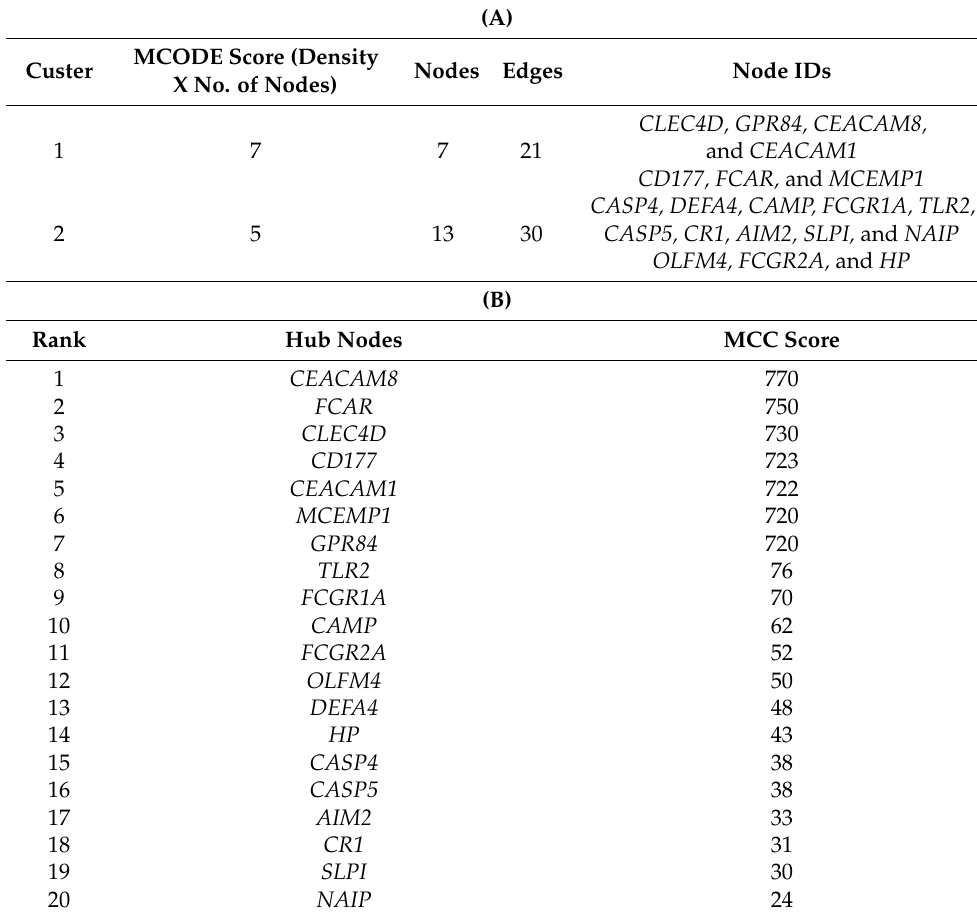
Table 4. ( A ) Closely interlinked regions in the PPI network are clustered by MCODE analysis. ( B ) Top-ranked hub nodes are categorized based on MCC